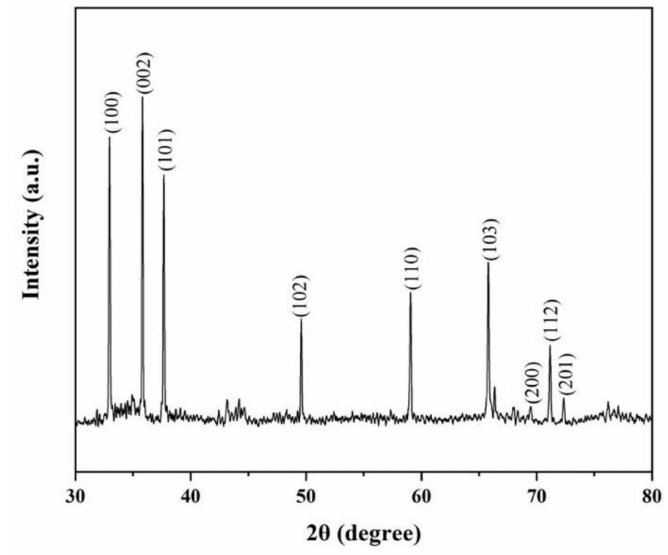
Figure 5. The XRD pattern of AlN